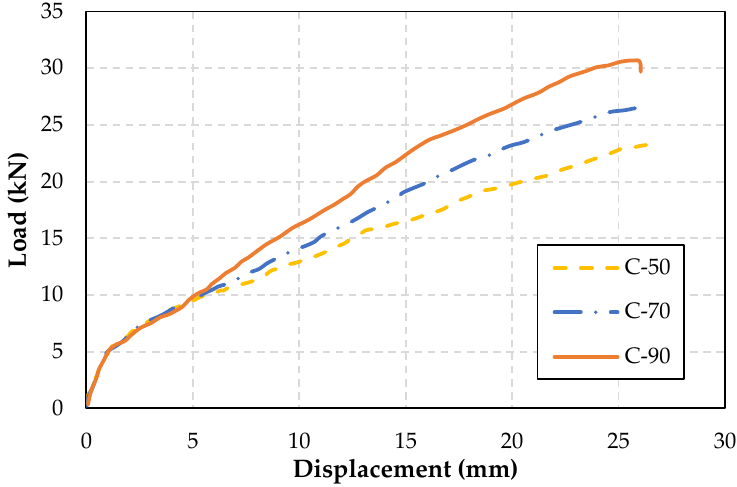
Figure 8. Effect of concrete compressive strength on the behavior of CFRP-strengthened